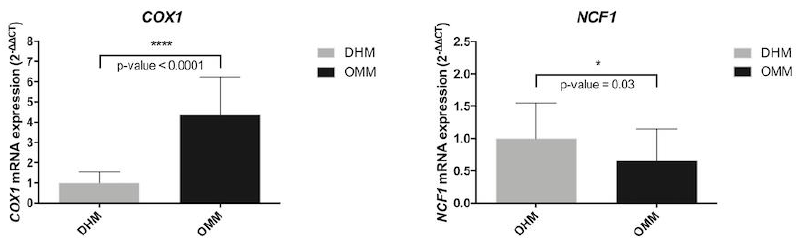
Figure 5. Real-time RT-PCR from RNA total of fecal samples from OMM and DHM to validate the biomarker genes COX1 and